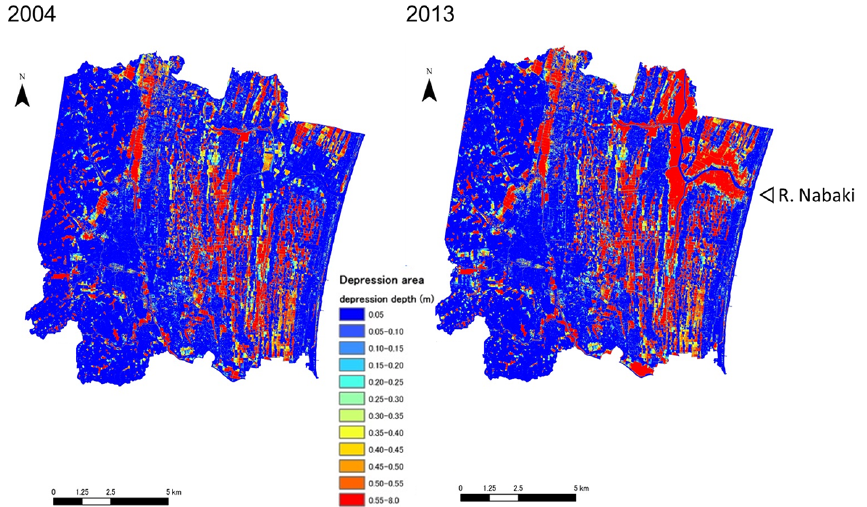
Figure 4. Distribution of depressions in 2004 and 2013. 1-m mesh digital elevation model obtained from the airborne laser scanning survey was used for the analysis.